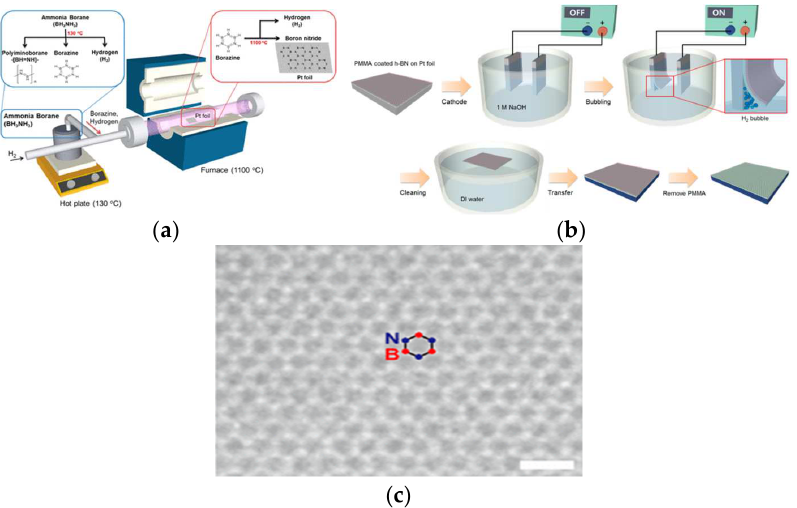
Figure 18. ( a , b ) Schematic diagrams of the LPCVD system used for h-BN growth and the electro- chemical bubbling-based method used to transfer the h-BN layer. ( c ) Atomic-resolution TEM image of single-layer h-BN [68].